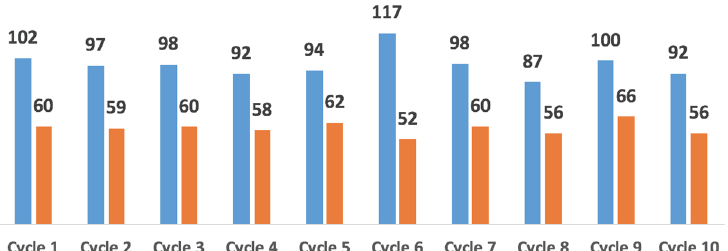
Figure 4. CO 2 adsorption and methanation cycles (10) using 10 grams of the Ru-Na 2 CO 3 DFM (5% Ru, 10% Na 2 CO 3 /Al 2 O 3 ) pellets in a fixed packed bed reactor with 7.5% CO 2 /N 2 at 320 °C. A 150-min of 5% H 2 /N 2 exposure was used during pretreatment followed by 10 identical CO 2 adsorption-methanation cycles. 5% H 2 /N 2 for 30 min was used for the methanation cycles. The volumes of CO 2 adsorbed and CH 4 produced are shown in the figure.